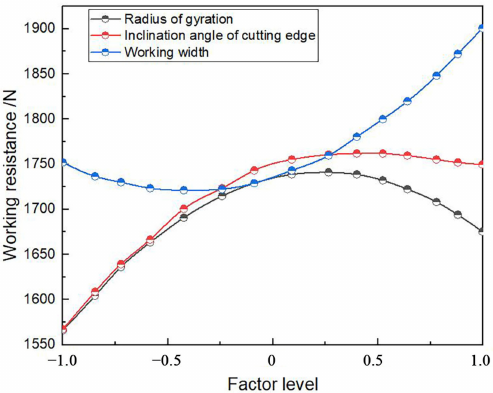
Figure 16. The relationship between each test factor and the working resistance. Combined with the work resistance analysis of variance, the test factors radius of gyration R , inclination angle of cutting edge β , and working width L interact with the work- ing resistance, as shown in Figure 17. P( AB ) = 0.8793, P( AC ) = 0.3668 and P( BC ) = 0.0658, indicating that there is no interactive effect of each test factor, which is consistent with the analysis of Table 6.